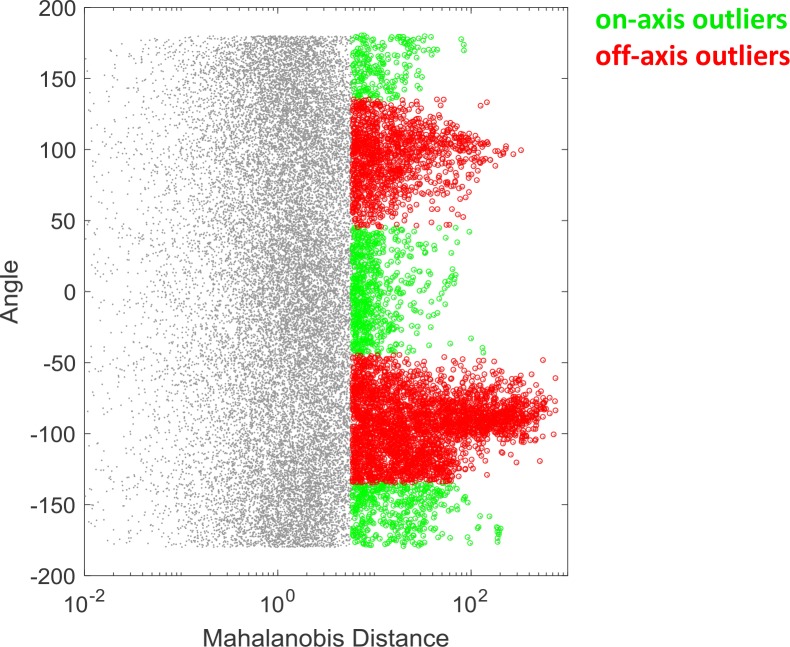
Identification of on-axis and off-axis outliers. The outliers of the screen (as exemplified in Figure 1B) were identified by thresholding (5% significance) the Mahalanobis distance. The outliers were then classified into on-axis or off-axis based on the angle of the data points with reference to the major principle vector. Specifically, outliers with an angle smaller than 45 degree were classified as on-axis outliers, and otherwise off-axis outliers. See Materials and methods - Analysis of the compound screen for details. The metadata from the compound screen can be found in Figure 1—source data 1. The source code used to visualize the results is presented in Figure 1—source code 1.